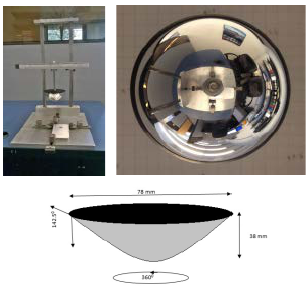
Figure 3: Constructed system (a: top left), corresponding camera image (b: top right) and mirror dimensions(c: